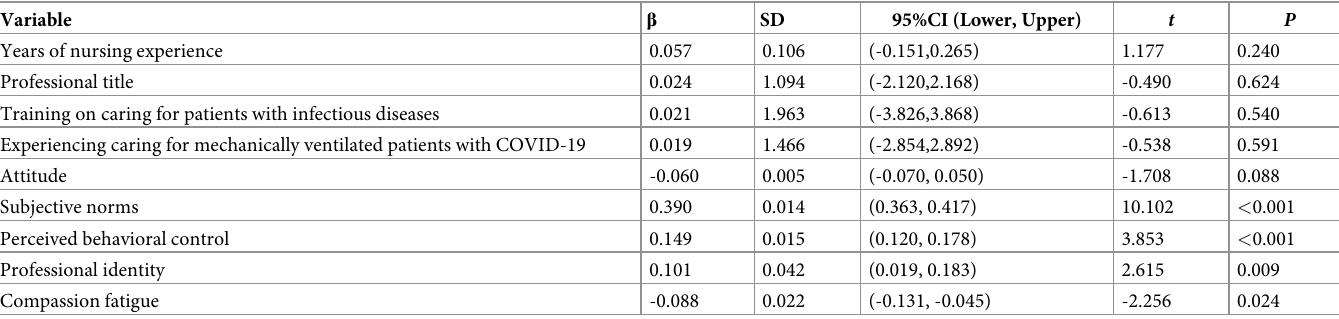
Table 4. Multiple linear regression of behavioral intention toward caring for COVID-19 patients on mechanical